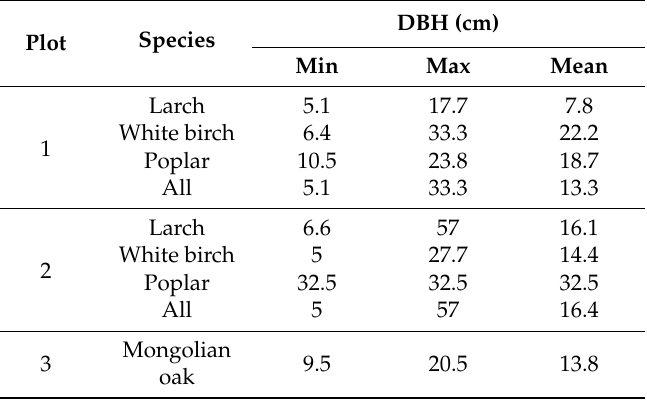
Table 1. Descriptive statistics of the diameter at breast height (DBH) for the test plots by tree species and all together. DBH (cm) Plot Species Min Max Mean Larch 1